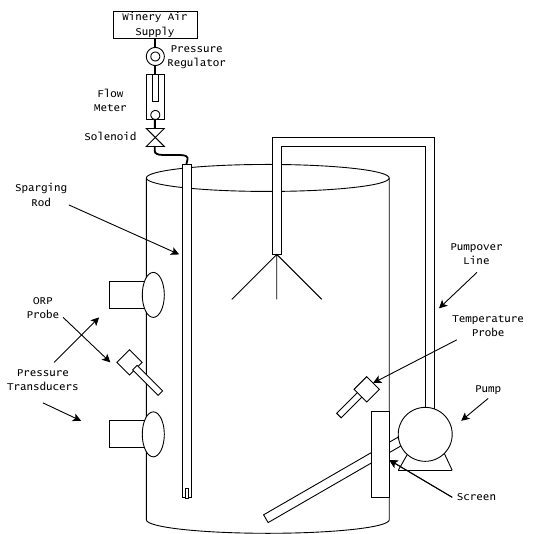
Figure 2. Experiment cross section at 100 L scale.